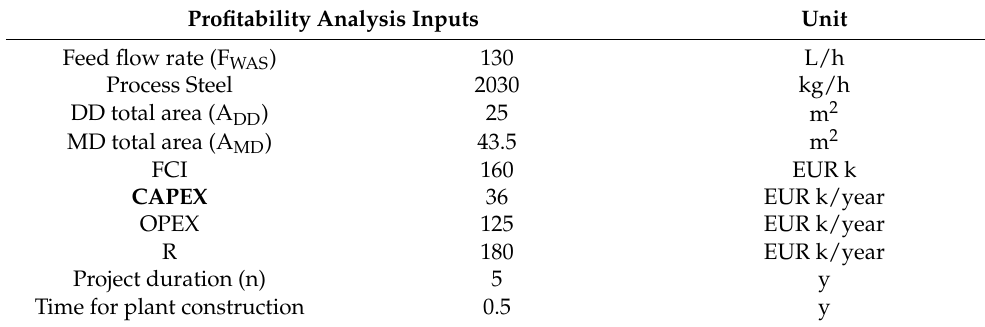
Table 6. Profitability analysis inputs for the Tecnozinco case study (ref. Future Size I in Table